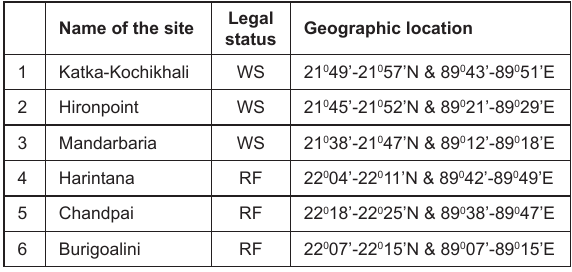
WS - Wildlife Sanctuary; RF - Reserve Forest were collected from September 2001 to February 2003. Tigers were identified using their stripe patterns (Schaller 1967; McDougal 1977; Karanth & Nichols